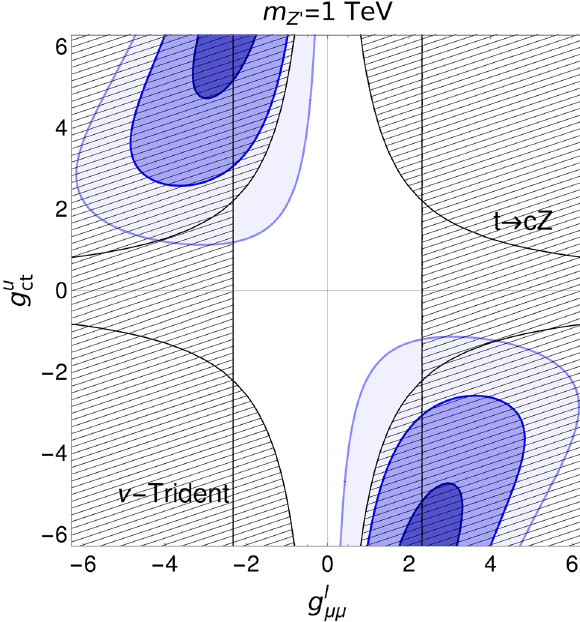
Fig. 6 Vector boson Z (cid:5) μ with m Z (cid:5) = 1 TeV and couplings g l μμ and g u ct . Dark, normal and light blue are the 1 , 2 , 3 σ preferred regions in our fit of flavour and electroweak observables. Shaded regions are excluded by other